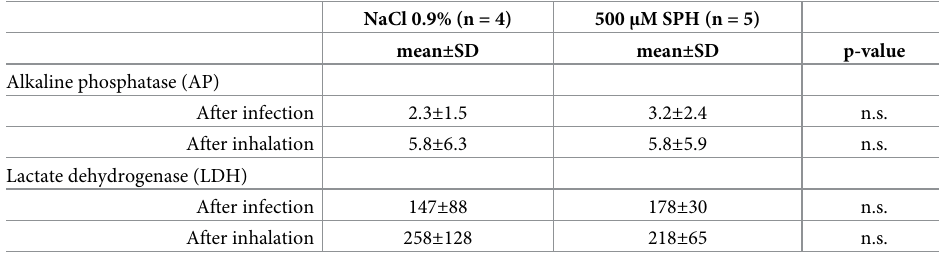
Table 4. Analysis of perfusate measurements during EVLP run.